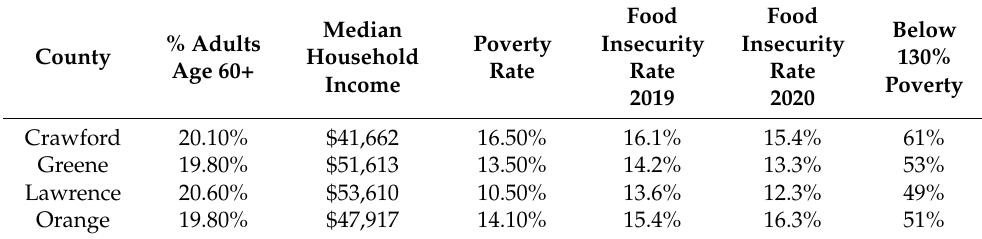
Table 1. Demographics of study